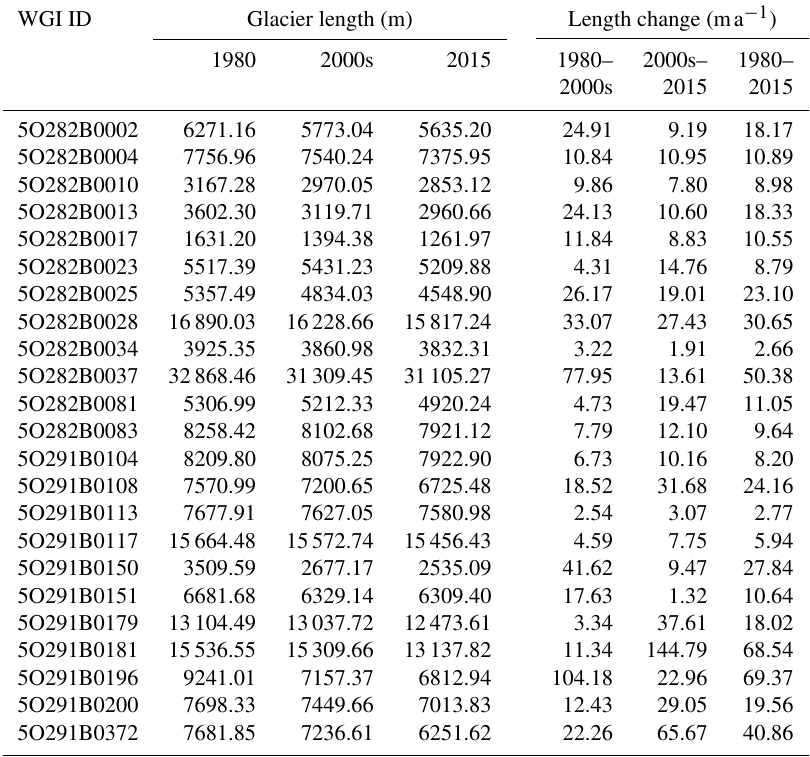
Table 6. Length change of glaciers in the Kangri Karpo. The uncertainties in glacier length in 1980, 2000s and 2015 are 6, 7.5 and 7.5m. The uncertainties in length change during the 1980–2000s, 2000s–2015 and 1980–2015 periods are 0.48, 0.71 and 0.27ma − 1